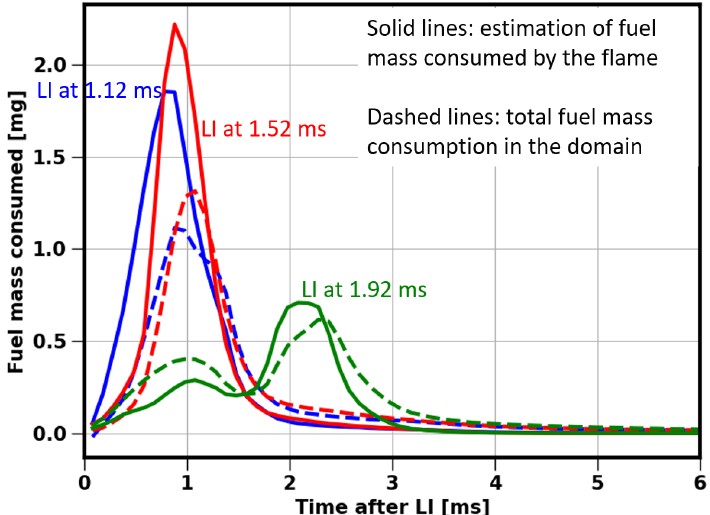
Figure 15. Fuel mass consumption after laser ignition using two approaches. First, by estimating the fuel mass consumed by the flame (solid lines). Second, by computing the total fuel mass in the computational domain (dashed